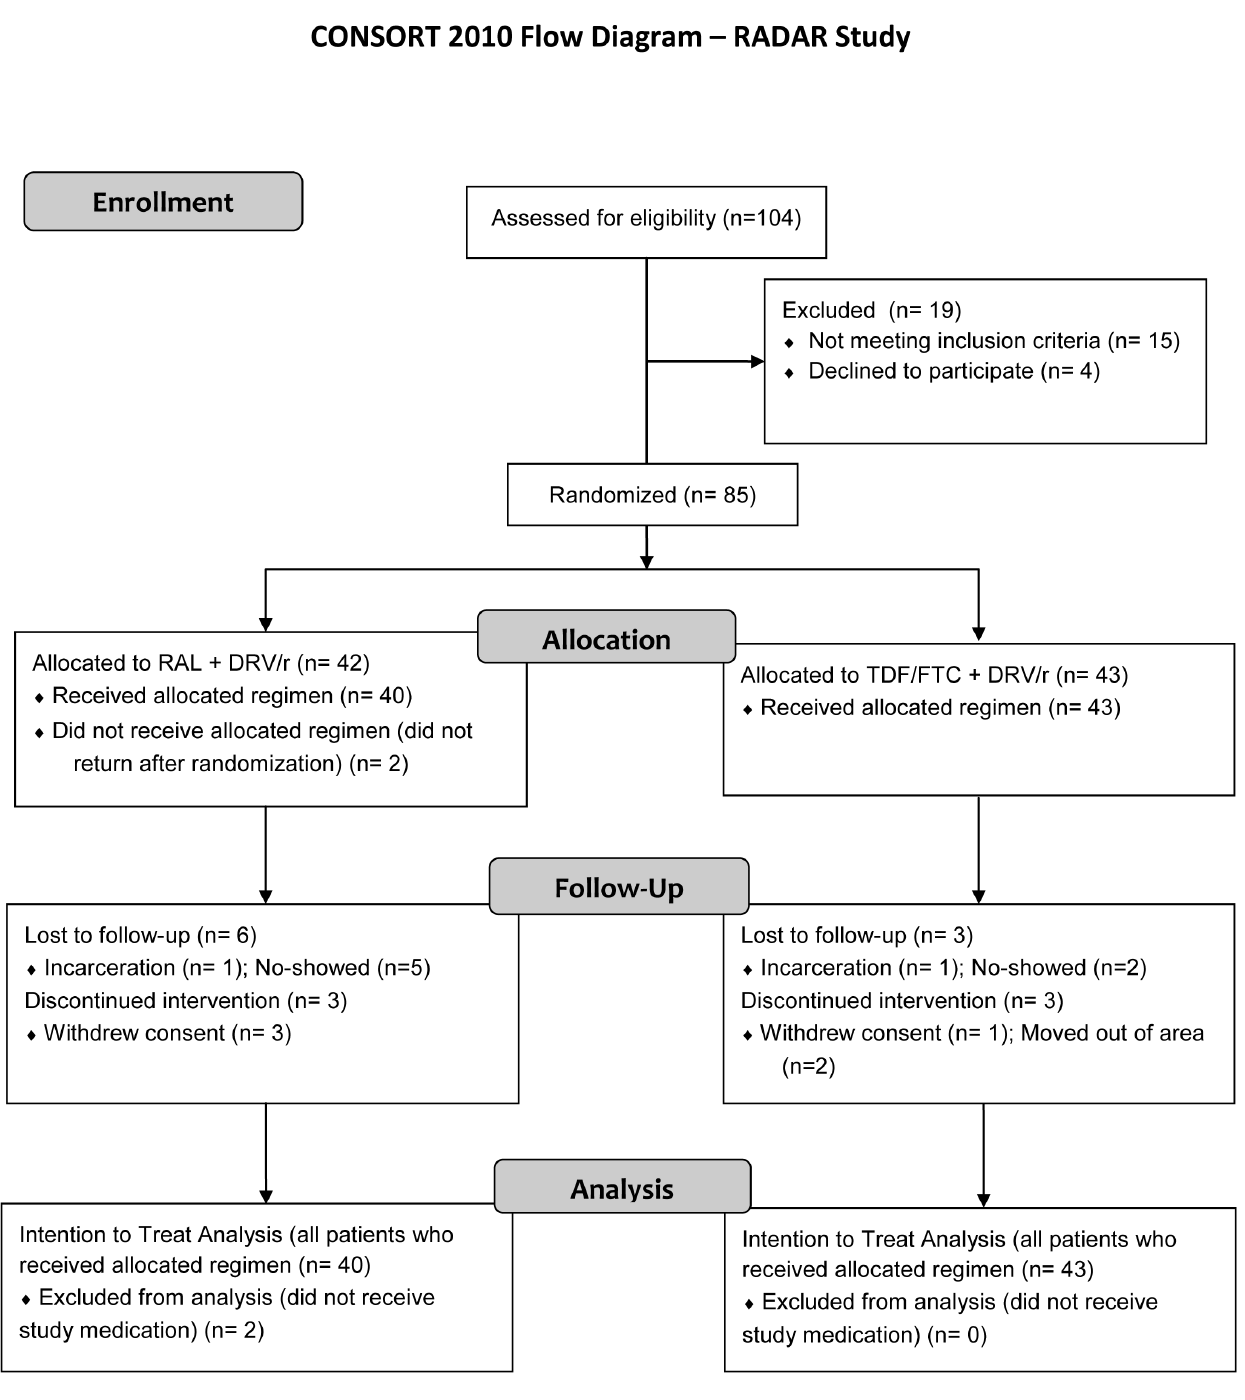
Figure 1. CONSORT Flow Diagram. doi:10.1371/journal.pone.0106221.g001 body and subtotal (total minus head) BMD, as well as fat and lean body mass. Fasting plasma samples were collected and frozen at 2 70 u C. Markers of inflammation and bone turnover were measured at weeks 0, 16, and 48. All assays were performed blinded to treatment group and BMD measurements. Inflamma- tory markers measured were: soluble tumor necrosis factor (TNF)- a , interleukin 1b (IL1-B), and IL-6 (Meso Scale Discovery, Rockville, MD). BTMs measured included C-terminal telopeptide